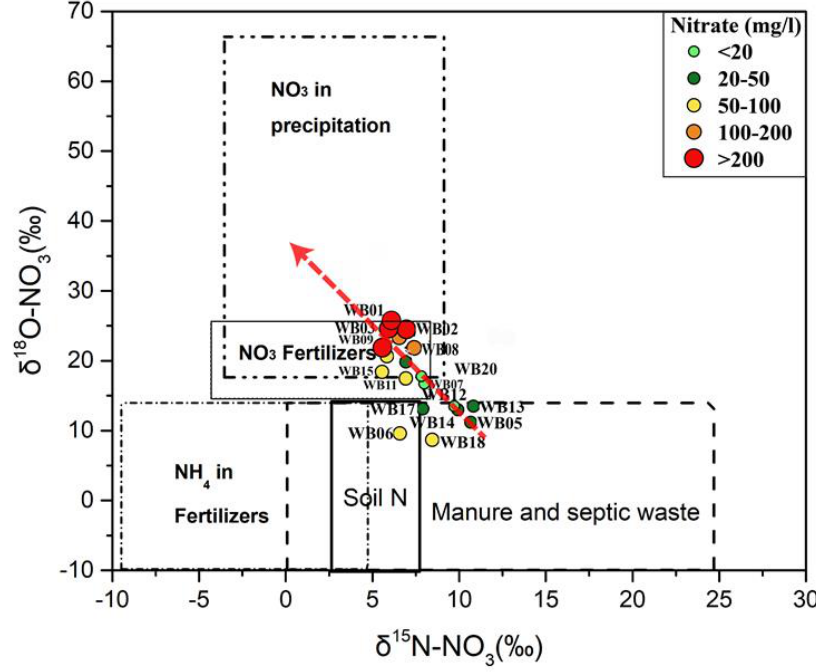
Figure 8. Relationship between δ 15 N NO3 and δ 18 O NO3 isotopes of analyzed groundwater samples from the study area. General ranges for the isotopic compositions of different types of common nitrate sources were adapted from Reference [35]. The increasing nitrification of Wasia groundwater by the influx of fertilizer is shown by the red arrow.